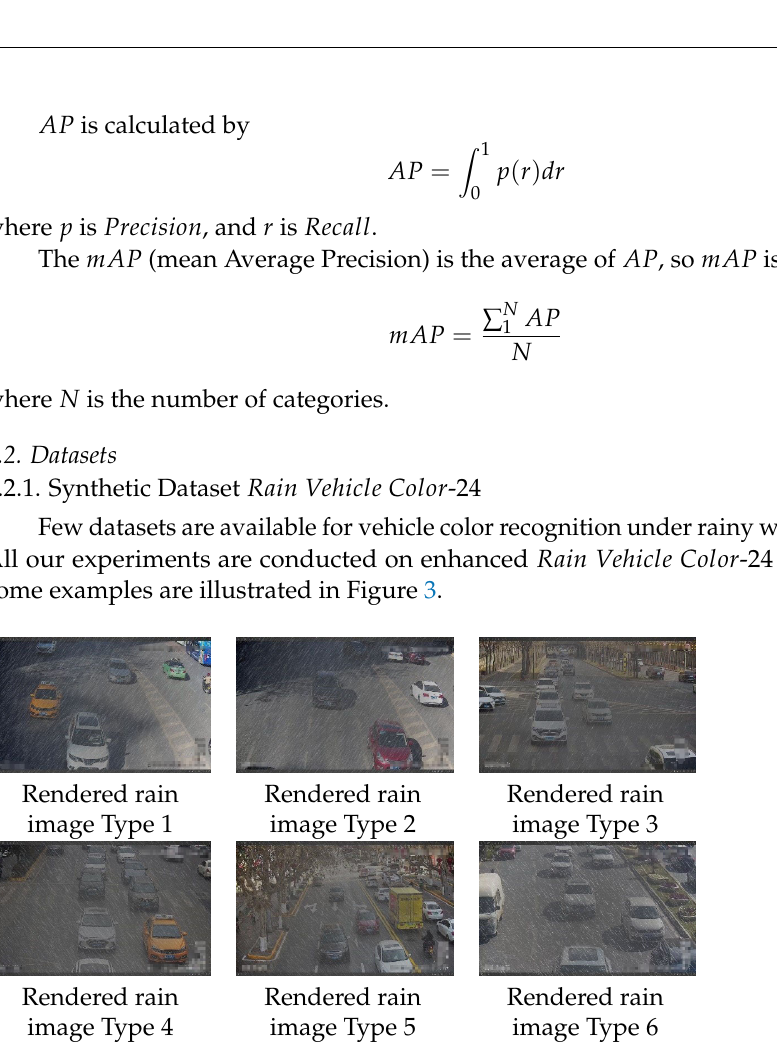
Figure 3. Examples from Rain Vehicle Color